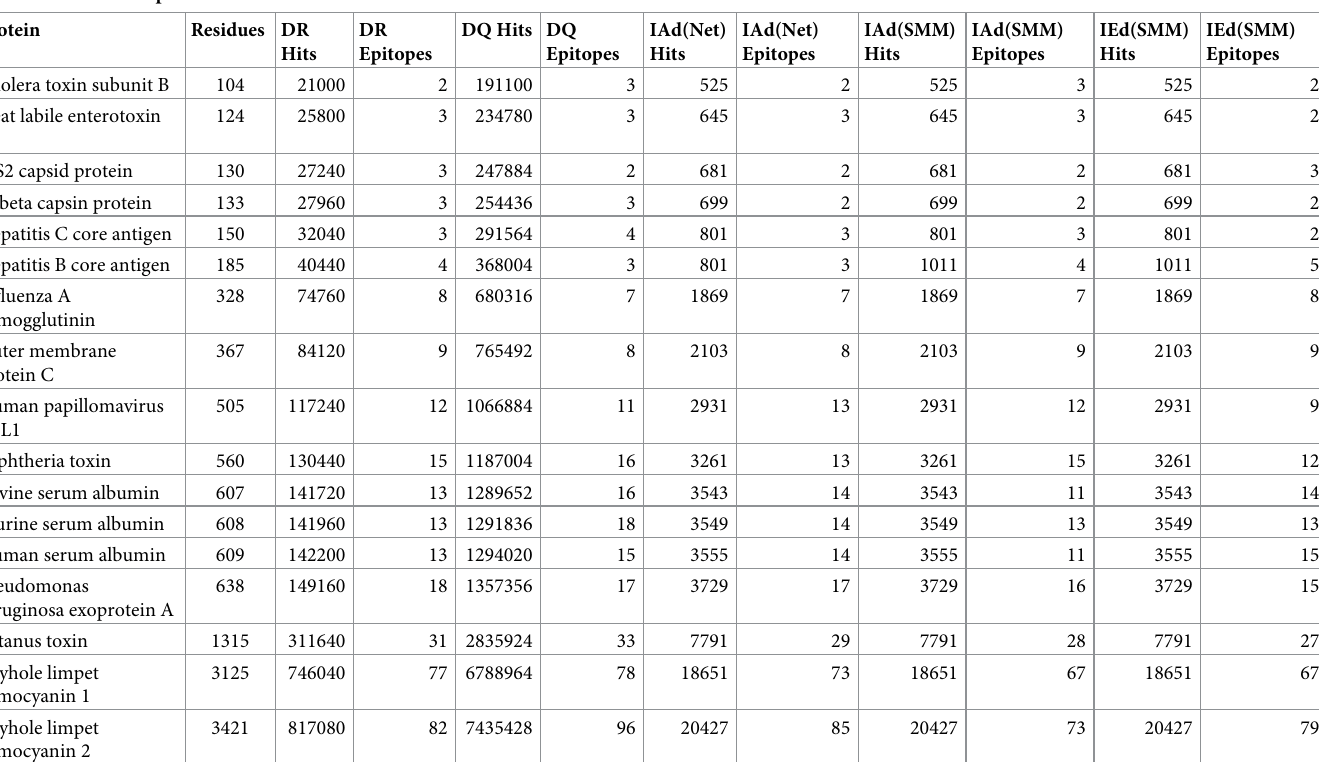
Table 2. Overview of prediction